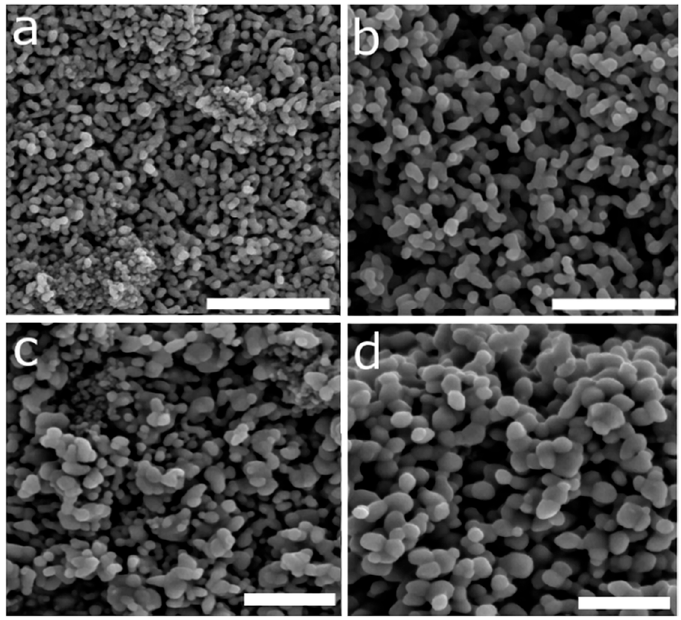
Figure 7. FE-SEM images of the ( a , b ) nanoshards, and ( c , d ) rhombohedral NP films synthesized by Hammond et al. after calcination, measured using a thin film coating (10 nm) of chromium. Scale bars depict 1 mm. Reproduced with permission from Reference